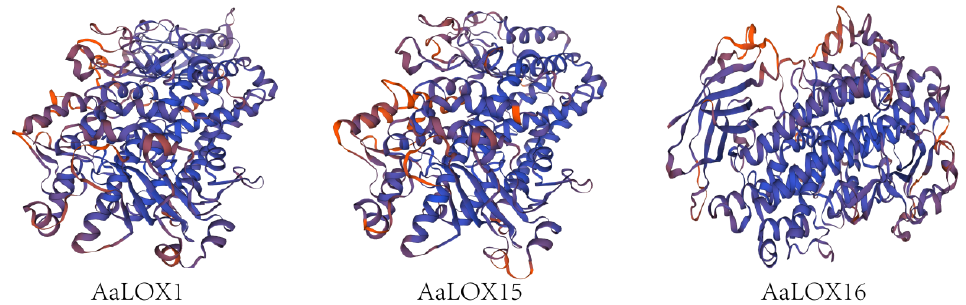
Figure 4. 3D structure of AaLOX protein sequences.